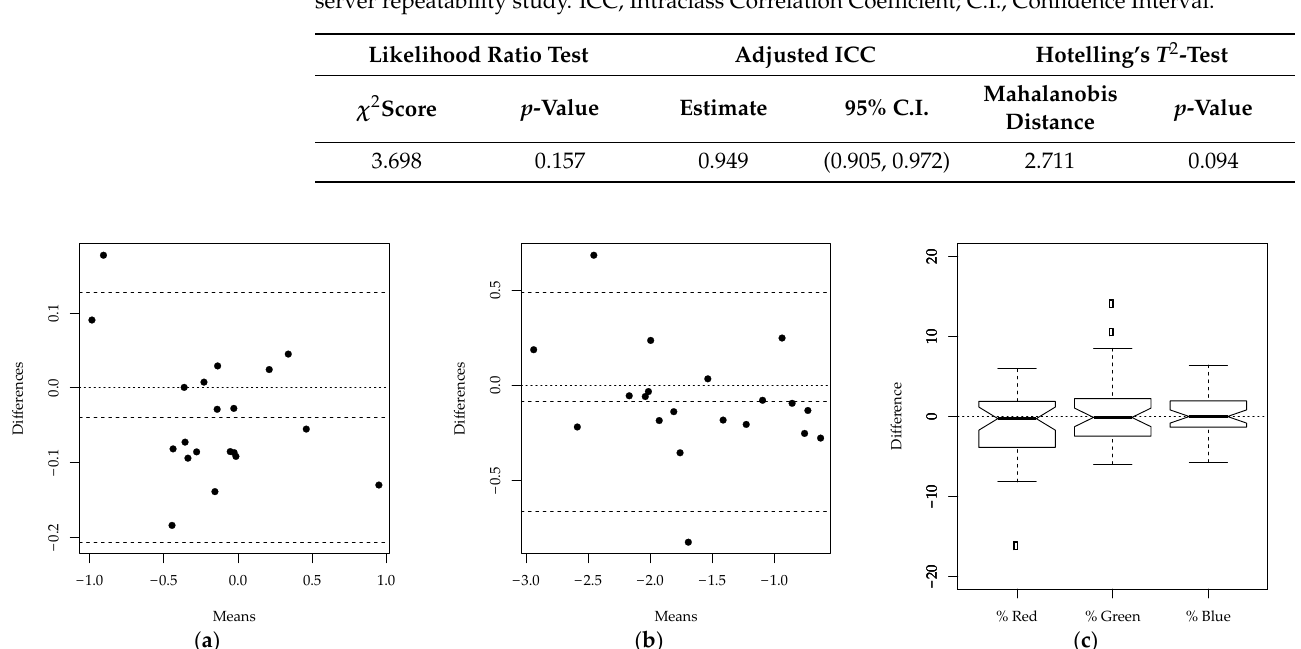
Figure 4. Intraobserver reproducibility study: ( a ) Bland-Altman plot—First dimension of isometric log ratio transformed data; ( b ) Bland-Altman plot—Second dimension of isometric log ratio transformed data; ( c ) Boxplots of the differences between the first and second measurement by VS for each color channel.